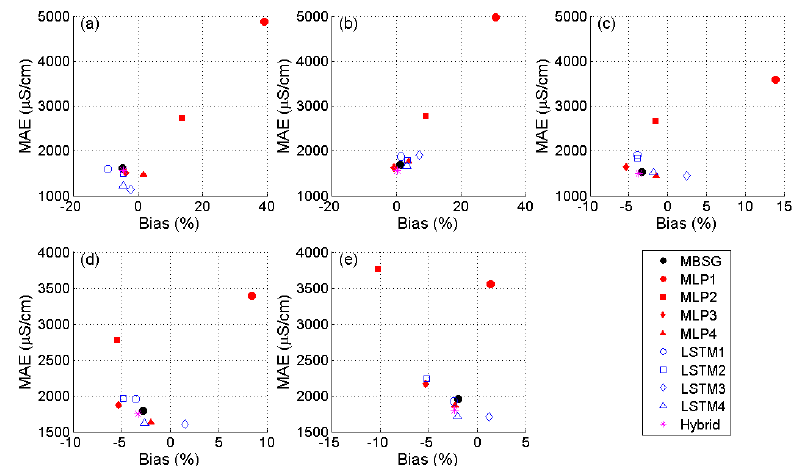
Figure 8. Percent bias (Bias; horizontal axis) and mean absolute error (MAE; vertical axis) between reference and simulated salinity at Martinez via di ff erent models grouped in five water year types including ( a ) wet year, ( b ) above-normal year, ( c ) below-normal year, ( d ) dry year, and ( e ) critical year.